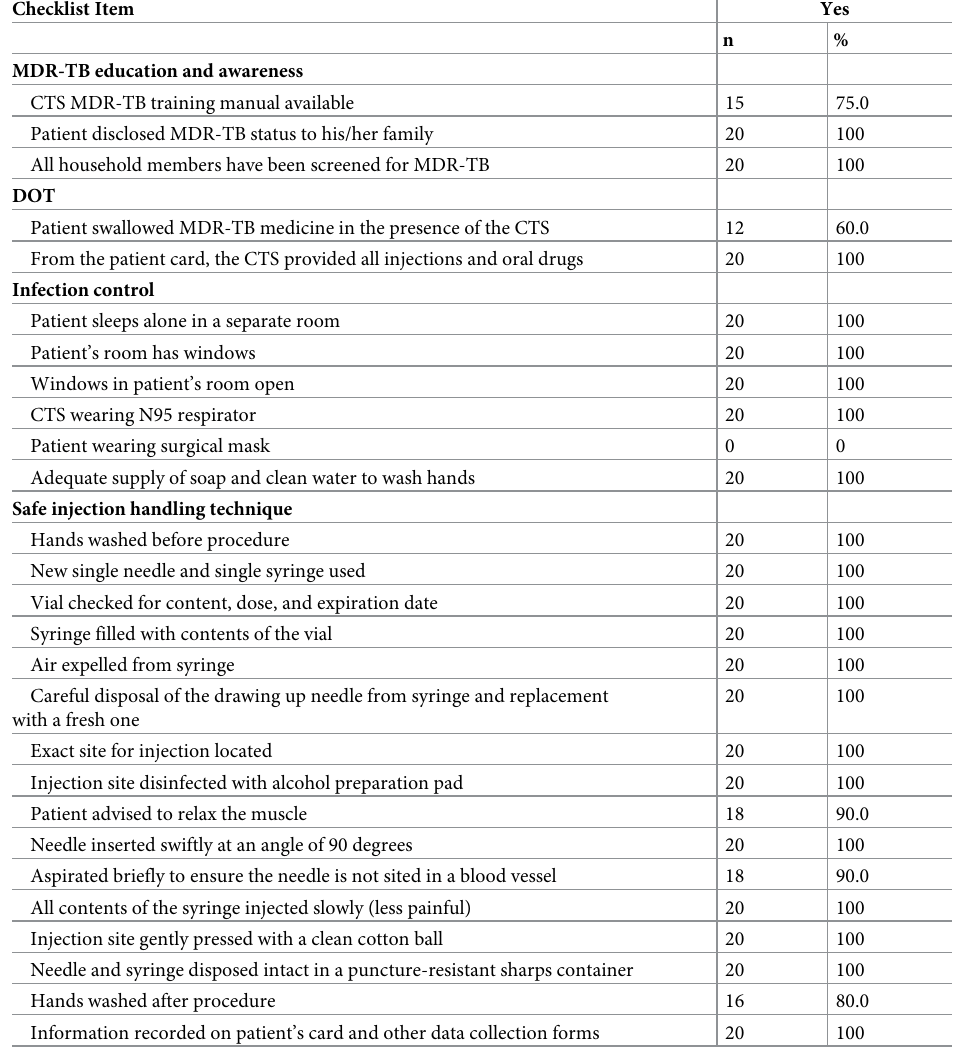
Table 5. Community based MDR-TB practices observed at patients’